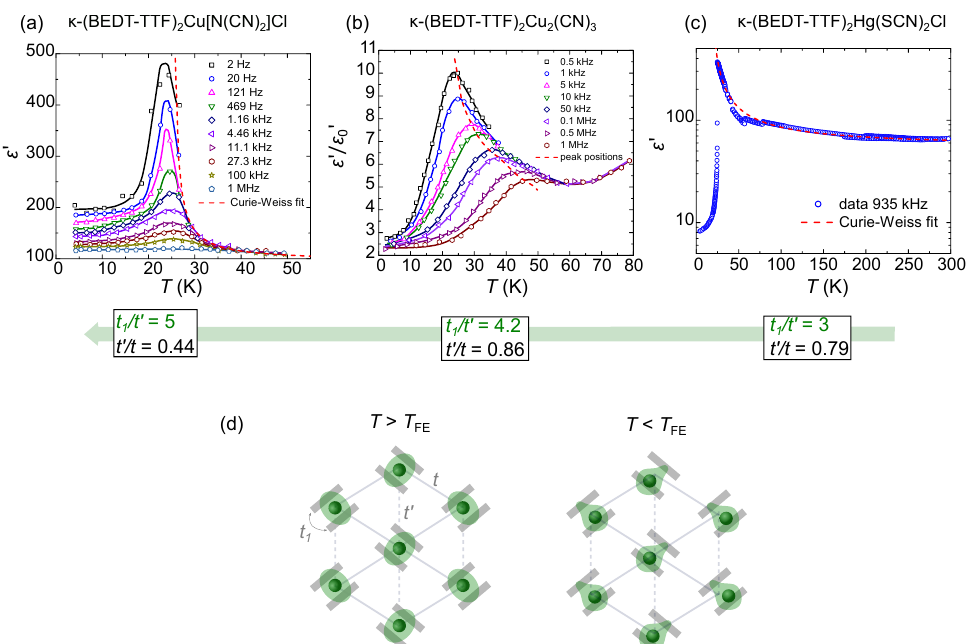
Figure 6. Role of intra-dimer charge degrees of freedom revealed by dielectric measurements: ( a – c ) Frequency-dependent dielectric constant (cid:101) (cid:48) on three κ -phase organic charge-transfer salts: ( b ) κ -(BEDT-TTF) 2 Cu[N(CN) 2 ]Cl ( κ -Cl) [16,84,88], ( c ) κ -(BEDT-TTF) 2 Cu 2 (CN) 3 ( κ -CuCN) [85] and ( d ) κ -(BEDT-TTF) 2 Hg(SCN) 2 Cl [86]. Symbols represent the measured data, solid lines are guide to the eyes. The red dashed lines represent Curie–Weiss fits of the data in ( b , d ), whereas they show the frequency dependence of the peak position in ( c ). These three materials differ by the degree of dimerization ( t 1 / t (cid:48) ), as well as the frustration strength ( t (cid:48) / t , defined in the effective dimer model). Values for t 1 / t (cid:48) and t (cid:48) / t for each of the materials are included below the figures and taken from Refs. [18,42,86]; ( d ) Schematic view of charge distribution on the dimerized κ -phase structure. For temperatures above the ferroelectric transition temperature (i.e., T > T FE ), charge is equally distributed within a dimer. For T < T FE , intra-dimer charge order sets in, giving rise to a macroscopic